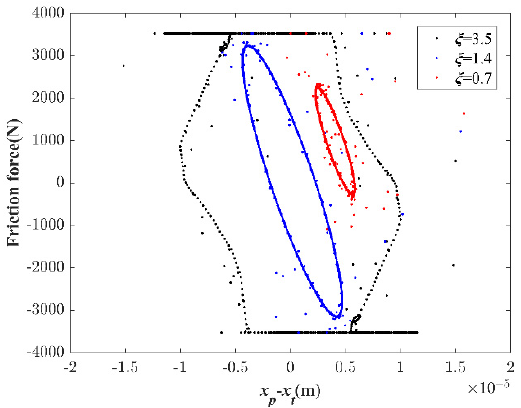
Figure 15. Hysteresis loops of friction damper for ξ = 0.7, 1.4, 3.5 .